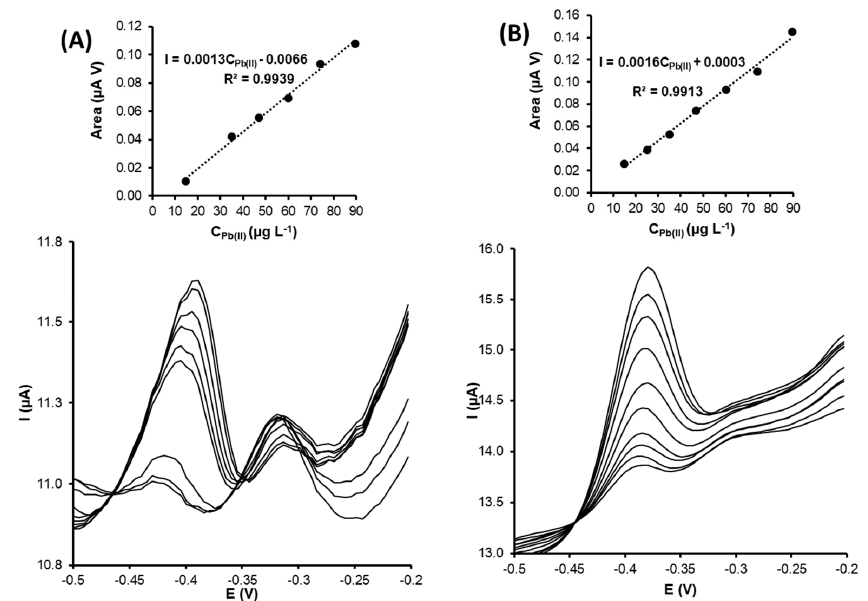
Figure 6. DPASV voltammograms for Pb(II) determination and its calibration curves (top inset) for ( A ) G-AgNPs-SPCNFE and ( B ) G-AuNPs-SPCNFE in acetic acid/acetate buffer 0.1 mol L − 1 pH